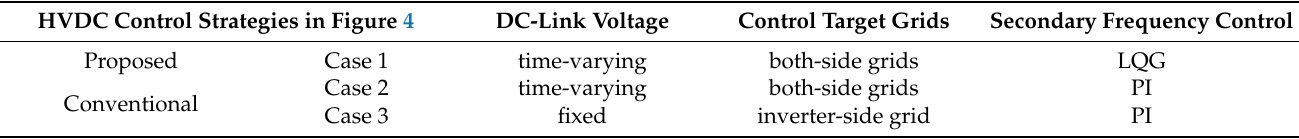
Table 3. Features of the proposed and conventional strategies.